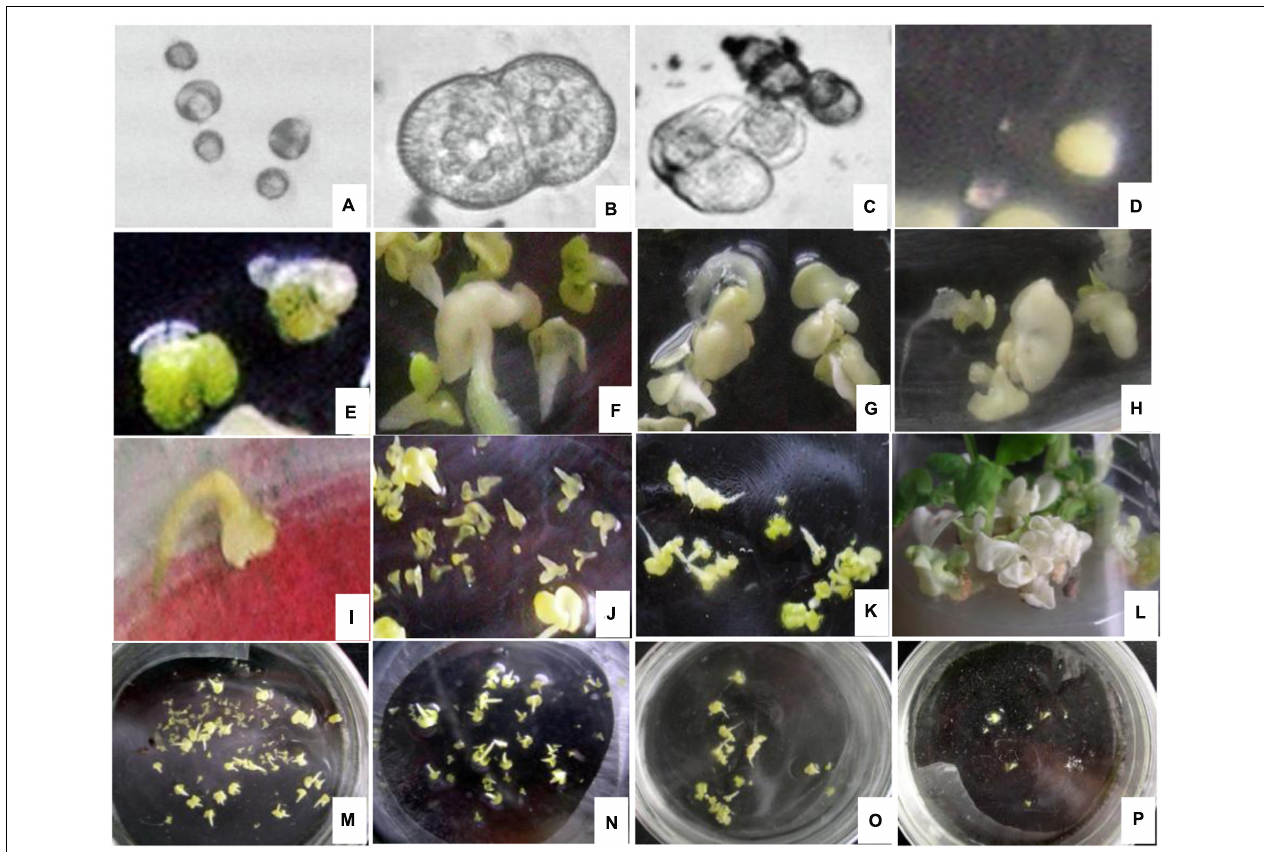
FIGURE 1 | Cytology of microspore embryogenesis with and without EMS treatment (A) Swollen cell observed after heat shock for 24 h. (B) Dividing cells after incubation in the dark for 2 to 3 days. (C) Cell cluster. (D) Globular embryo observed after incubation in the dark for 7 to 14 days. (E) Heart-shaped embryo. (F) Cotyledon embryos. (G,H) Deformed embryo. (I) brown and died embryo. (J) Lagging embryo development. (K) Albino embryo. (L) Albino seedlings. (M) Embryo production without EMS. (N) Embryonic development with 0.03% EMS treatment. (O) Embryonic development after 0.05% EMS treatment. (P) Embryonic development after 0.1% EMS treatment. (A–F,M) without EMS; (G–L and N–P) with